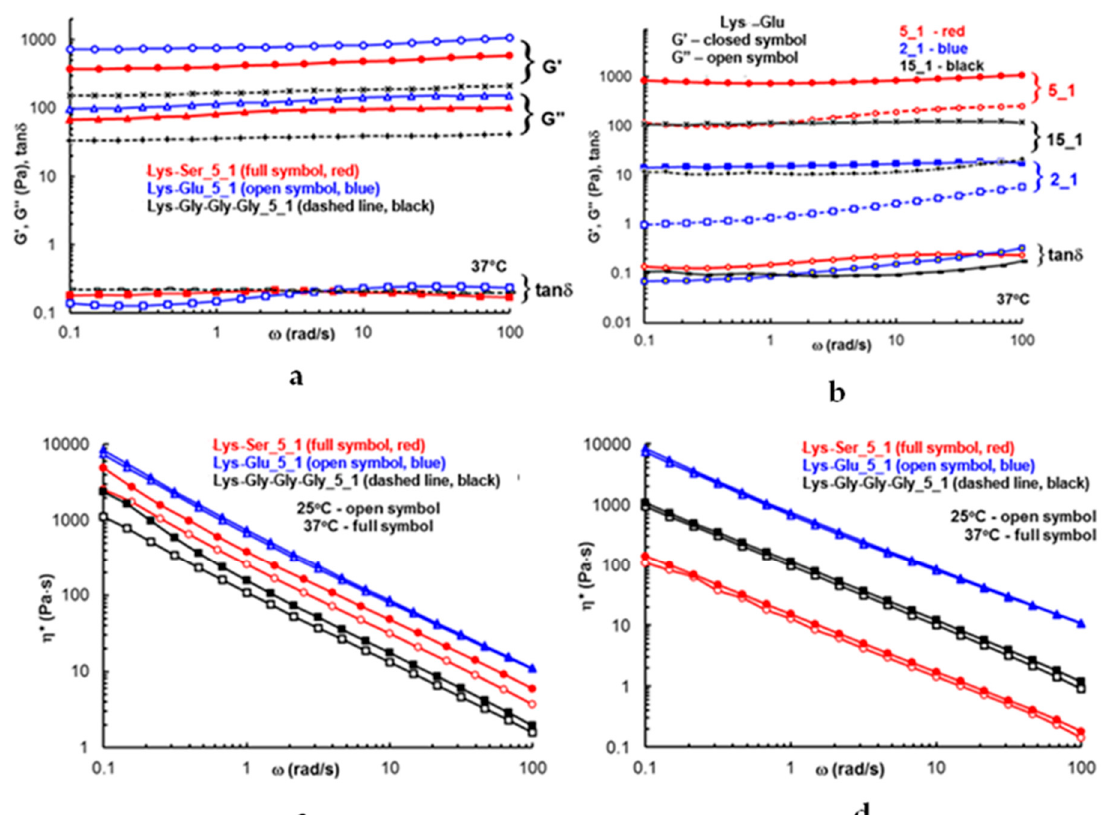
Figure 6. The viscoelastic parameters (G’, G” and tan δ ) ( a , b ) and complex viscosity ( c , d ) as a function of oscillation frequency for Lys-based samples for a constant ratio of 5_1 between the components ( a , c ) and for Lys_Glu pairs at different ratios ( b , d ), at 37 °C and 25 °C, as shown in each plot.